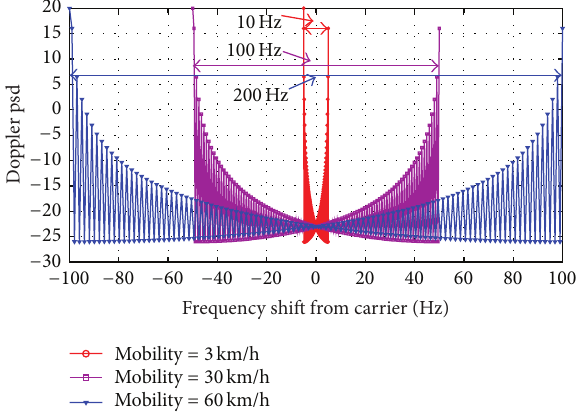
Figure 5: PSD of the PS 3D triple-polarized channel model.